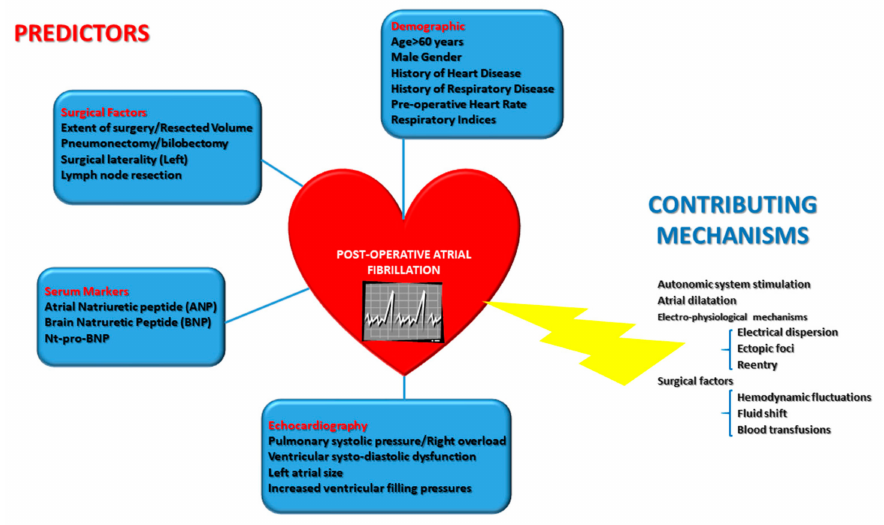
Figure 2. Graphical depiction of post-operative atrial fibrillation «milieu»—Independent predictors derived from principal studies from literature are in boxes, according to their type. Contributing mechanisms, including electro-physiological ones, are in